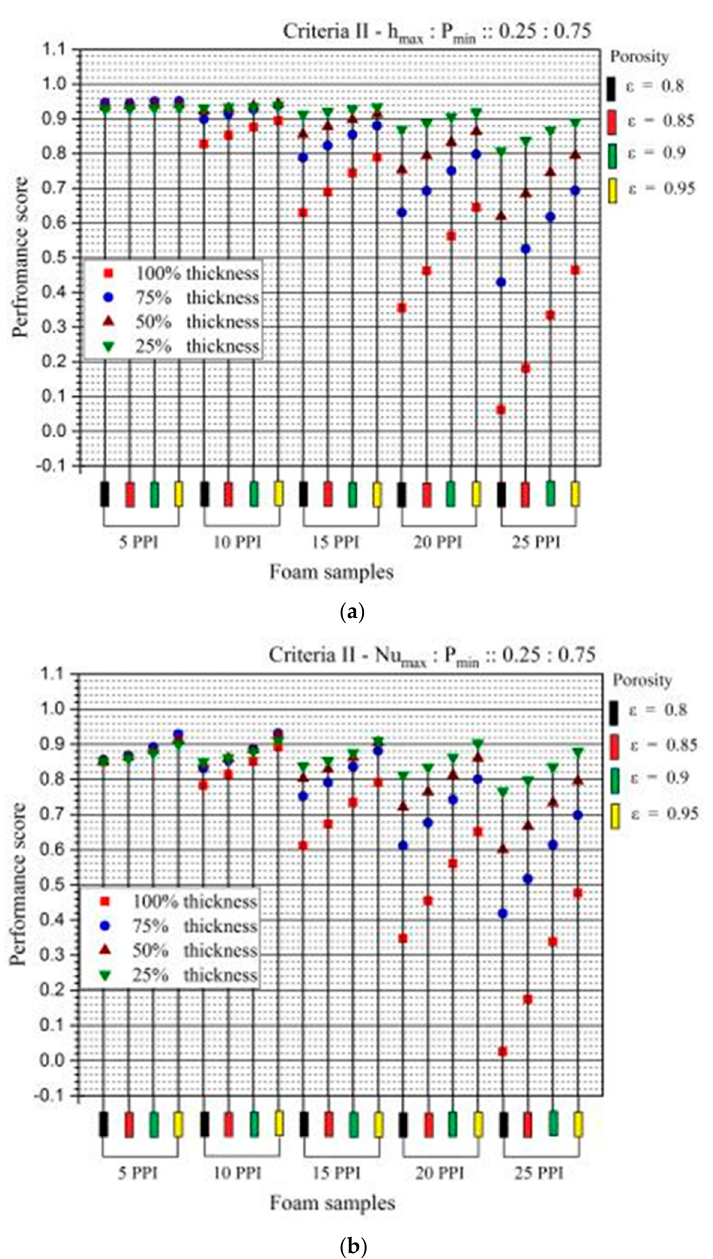
Figure 11. ( a ) Criteria II (h max :P min ). ( b ) Criteria II (Nu max :P min ). Criteria 3 (h max :P min :: 0.5 : 0.5 and Nu max :P min :: 0.5 : 0.5) represents the case where equal